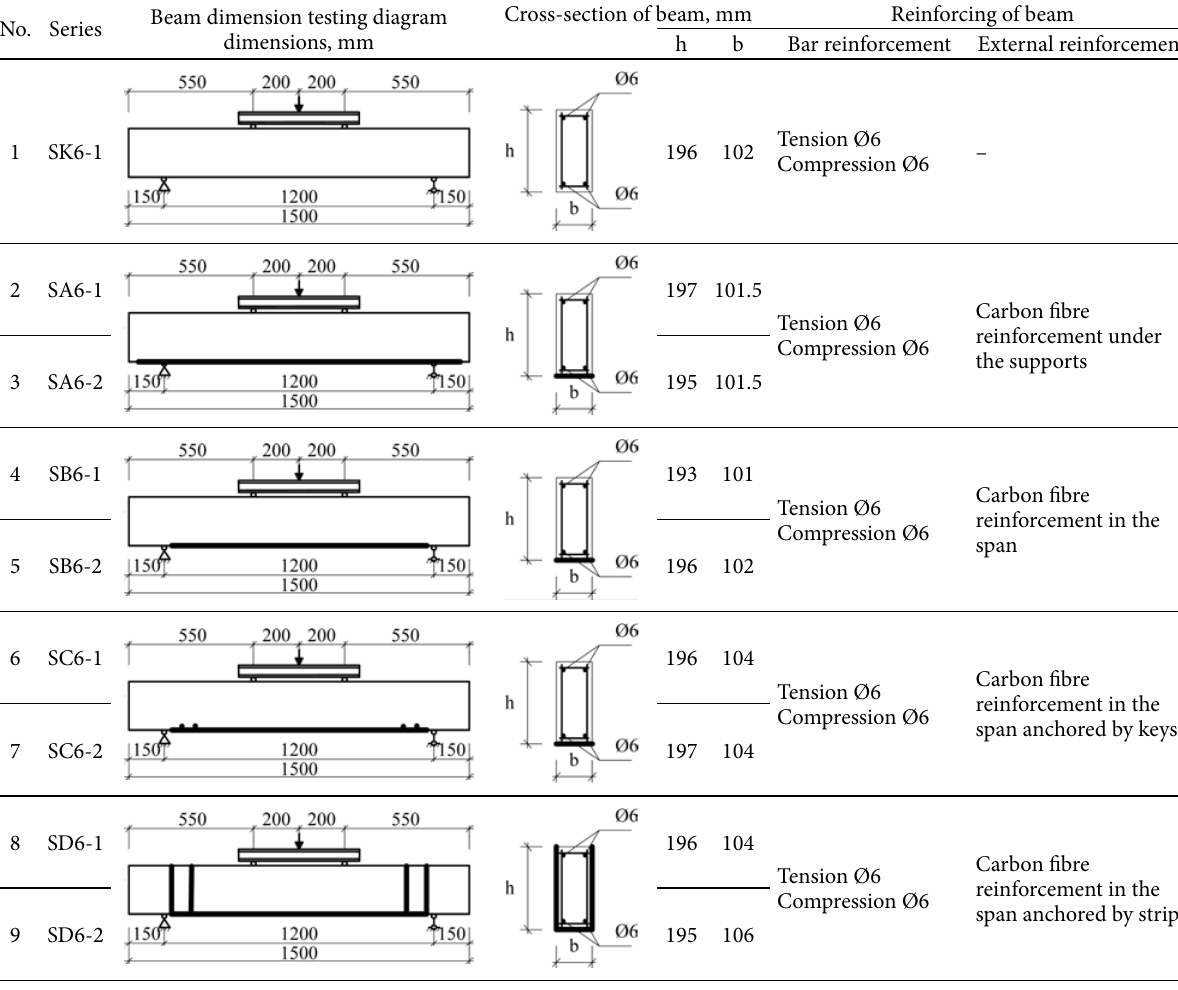
Cross-section of beam,